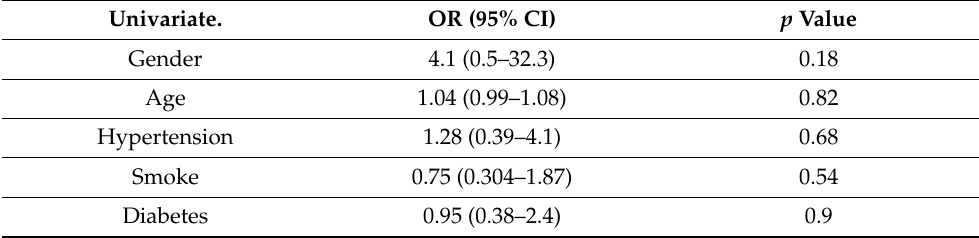
Table 2. Univariate analysis and multivariate analysis 1 (MV1) including SS I and multivariate analysis 2 (MV2) including SS II. Statistical significance between VT/VF episodes occurrence and SS II was always observed even after adjustment for all the covariates; panel C shows the best